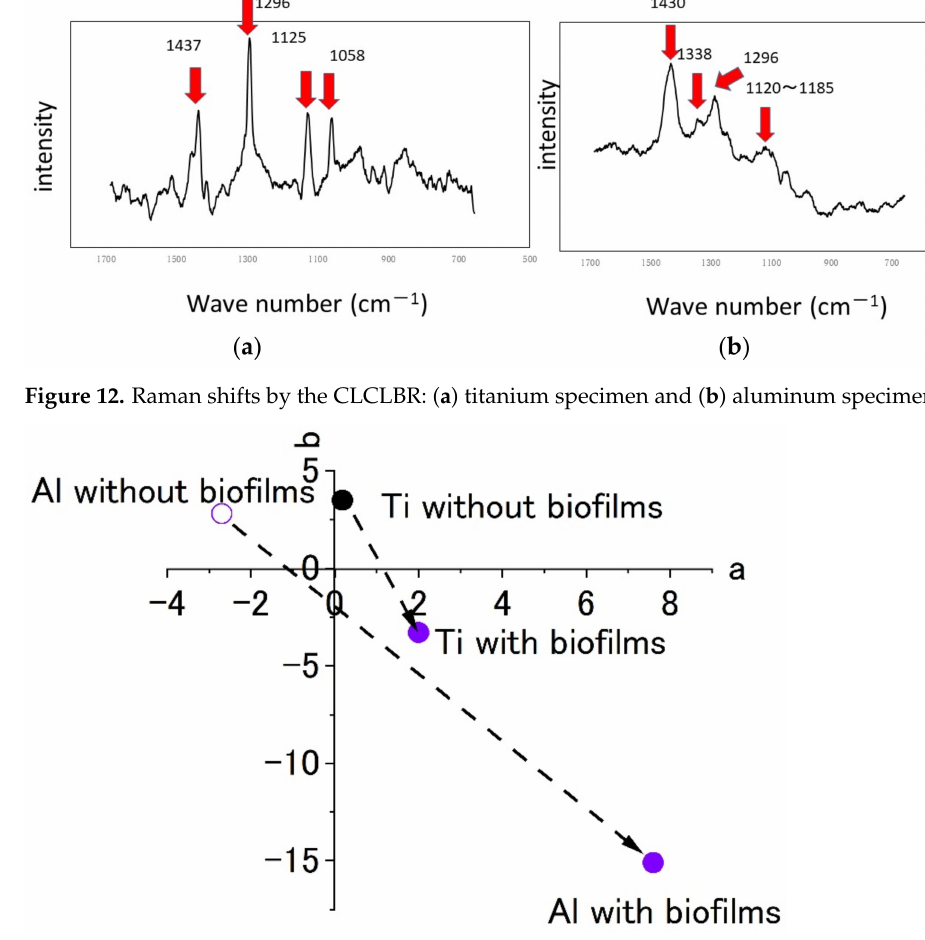
Figure 13. The color changes in specimens’ surfaces stained by 0.1% crystal violet in the CLCLBR. (a) complementary color dimension between red and green. (b) complementary color dimension between yellow and